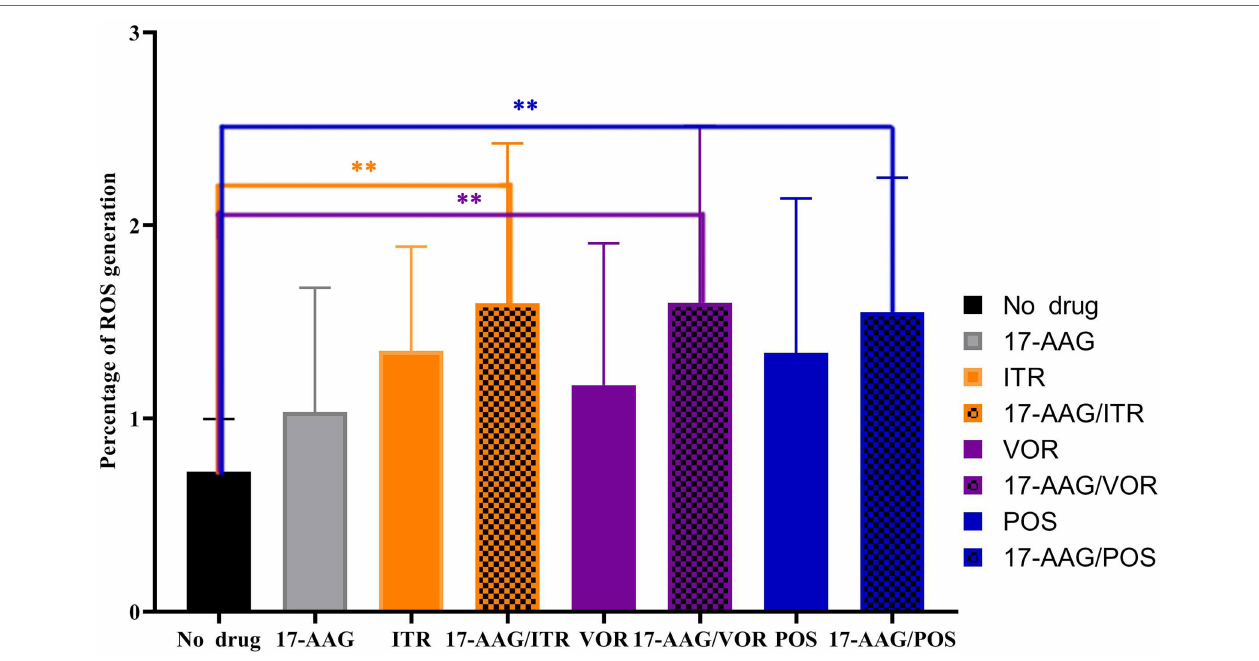
FIGURE 5 | 17-AAG and azole alone and in combination, extracellular ROS production level. ** p <